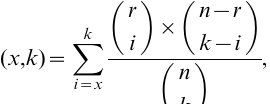
Table S1 Complete predicted antimalarial target space of 226 P. falciparum proteins and their assigned compounds. Table S2 Complete list of target profiles predicted for phenotypically active